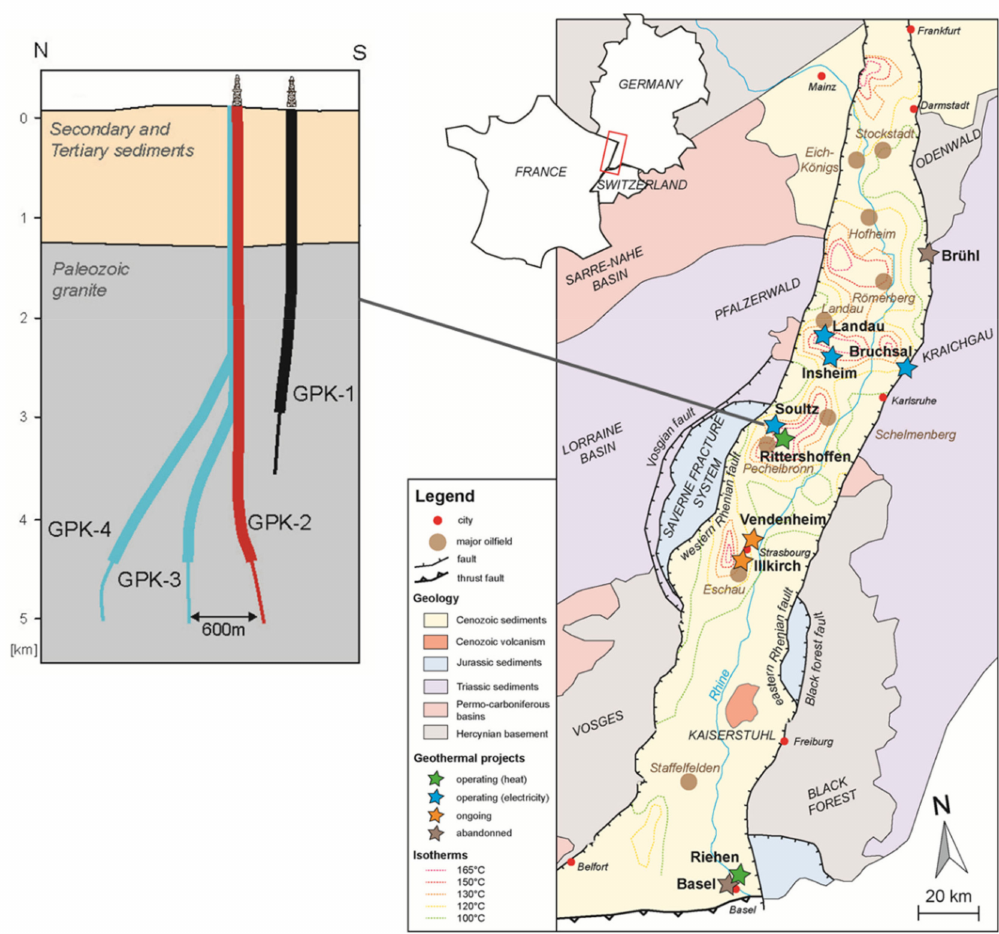
Figure 1. Map of the Upper Rhine Graben and schematic drawing of the deep wells at SsF geothermal plant